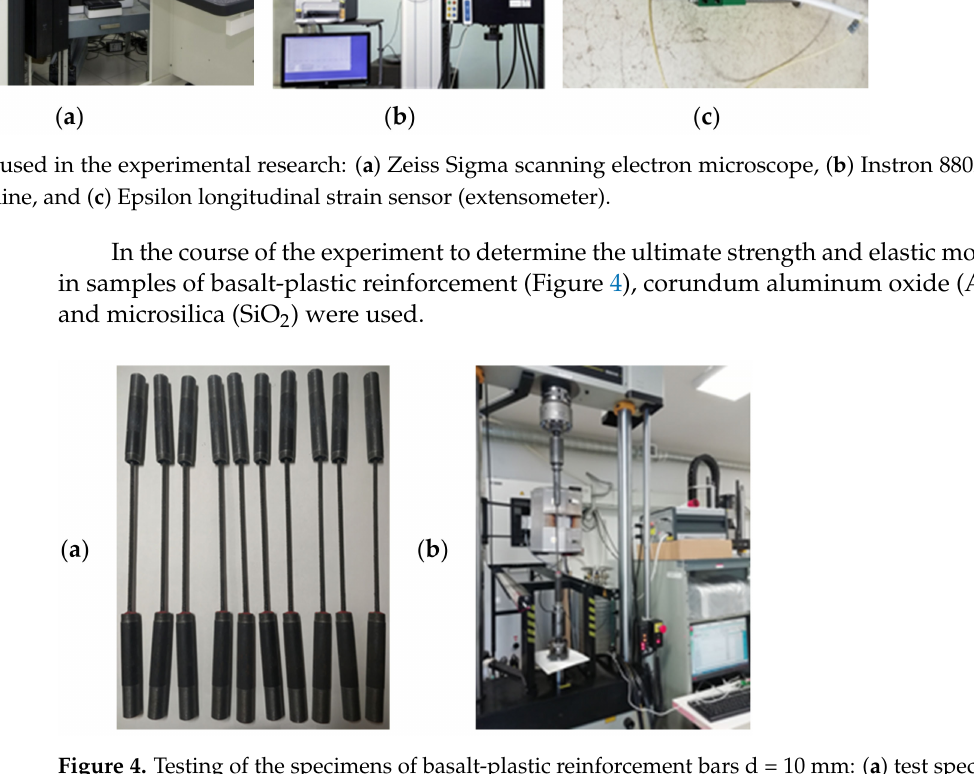
Figure 4. Testing of the specimens of basalt-plastic reinforcement bars d = 10 mm: ( a ) test specimens, and ( b ) testing machine with a